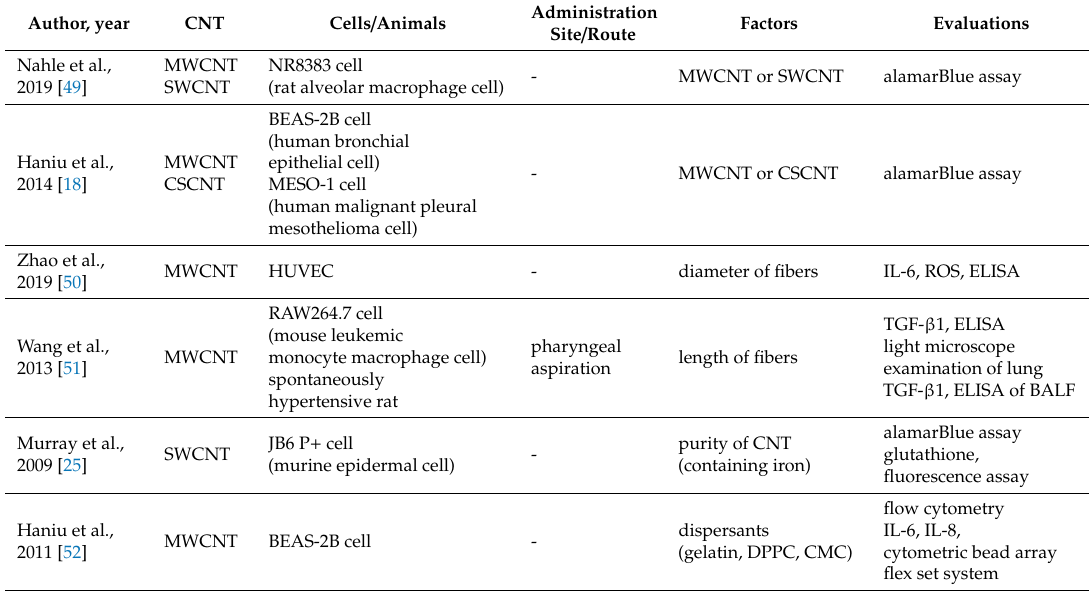
Table 4. Factors a ff ecting the biocompatibility testing of